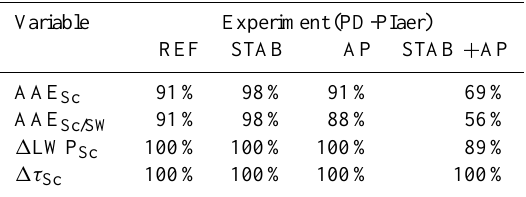
Table B1. Probability computed with an unpaired two-tailed t test with unequal variances applied to annual mean values of the present-day and preindustrial aerosol (climatological) simulations of an experiment in which the differences between present-day and preindustrial aerosol simulations are not occurring by chance. AAE is the anthropogenic aerosol effect, LWP is liquid water path, τ is aerosol optical depth, and 1 represents the difference between present-day and preindustrial aerosol emissions. The subscript Sc represents values in the stratocumulus regime. Values <90% are considered not statistically significant. Variable